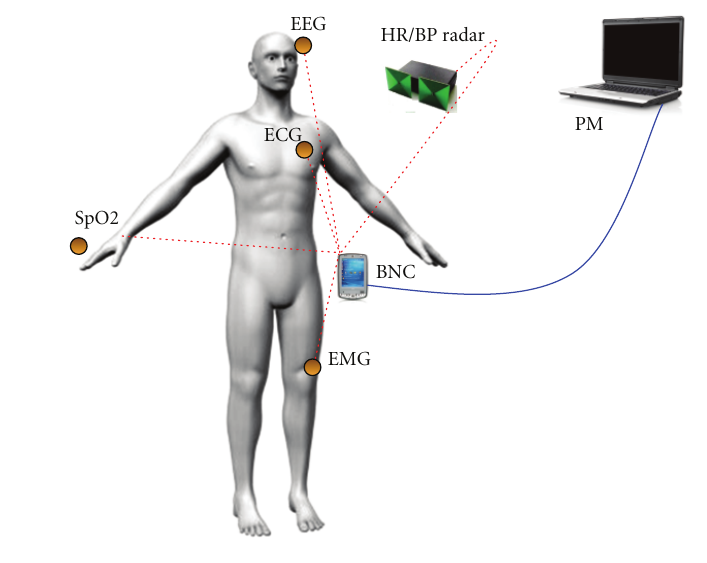
Figure 1: Network Topology of an